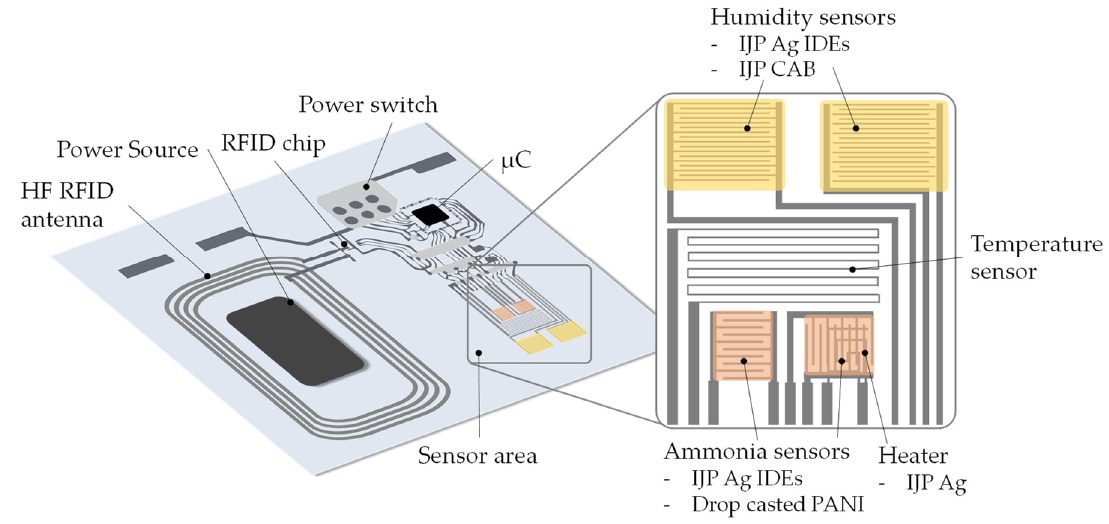
Figure 8. RFID enabled printed multisensor system [30].